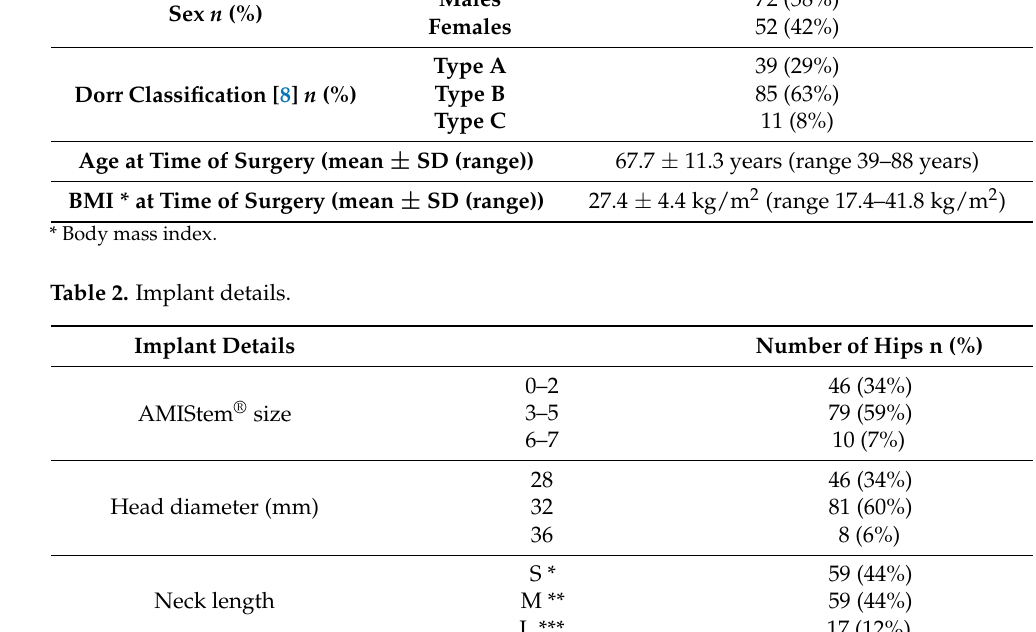
Table 1. Patient demographics (N = 124 patients, N = 135 hips). Sex n (%) Dorr Classification [8] n (%)